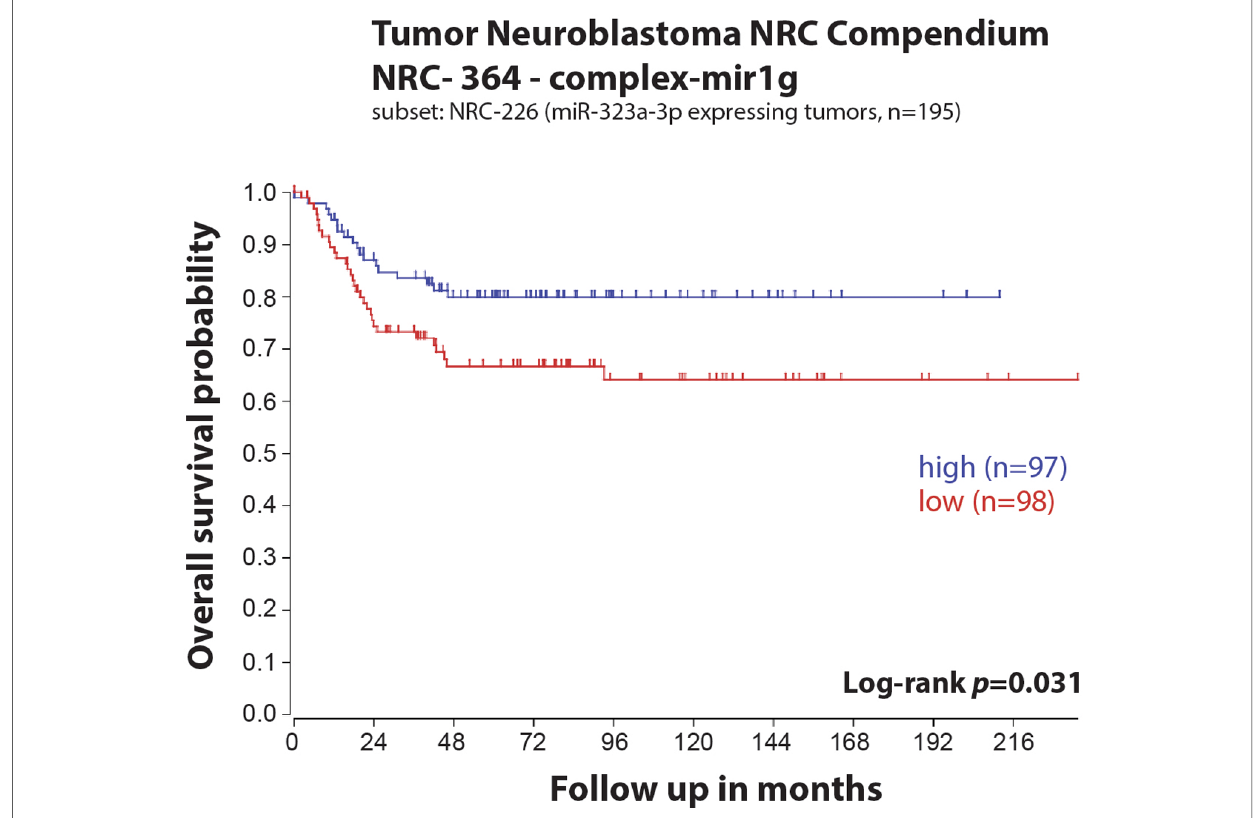
FIGURE 1 Low expression of miR-323a-3p is associated with poor overall survival in a primary neuroblastoma tumors dataset. Kaplan-Meier overall survival curve for patients with high (blue, n =97) and low (red, n =98) expression of miR-323a-3p